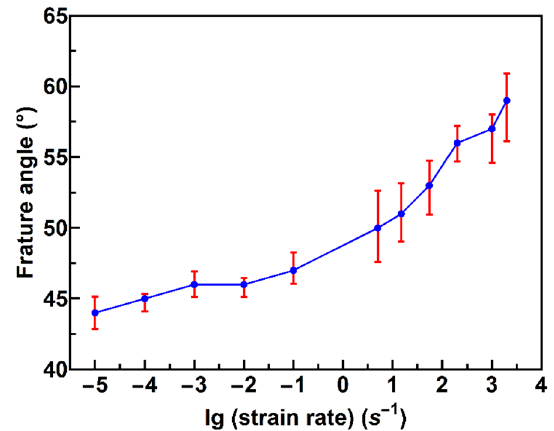
Figure 7. Variation of fracture angle based on the strain rate.